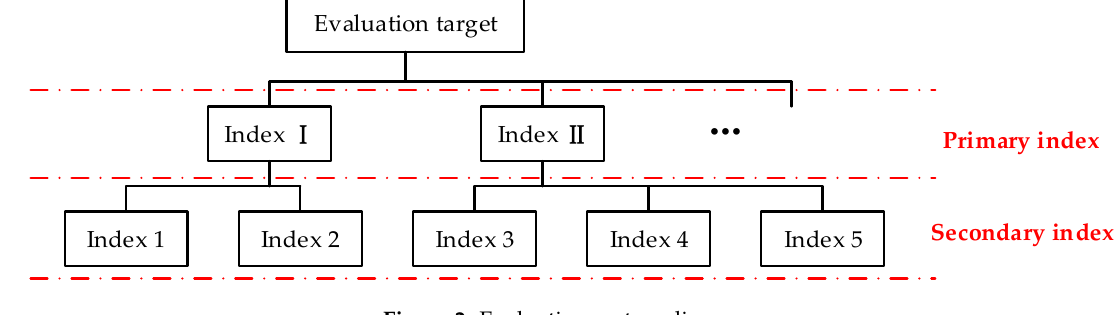
Figure 2. Evaluation system diagram.